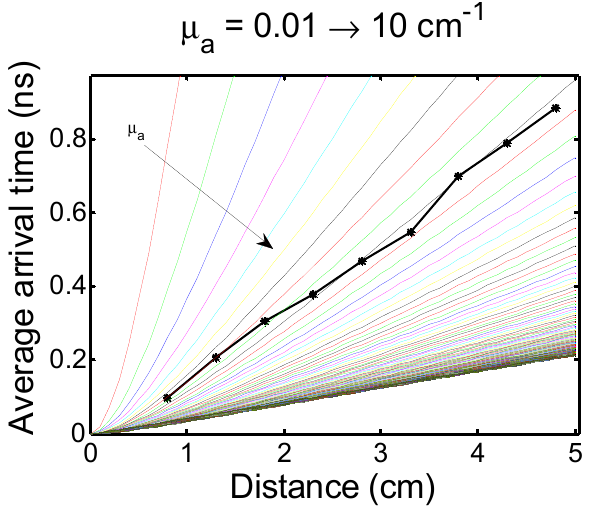
Figure 4. Average arrival time of photons: theoretical (colored continuous lines) and measured in back diffusion configuration on the phantom (black connected points).